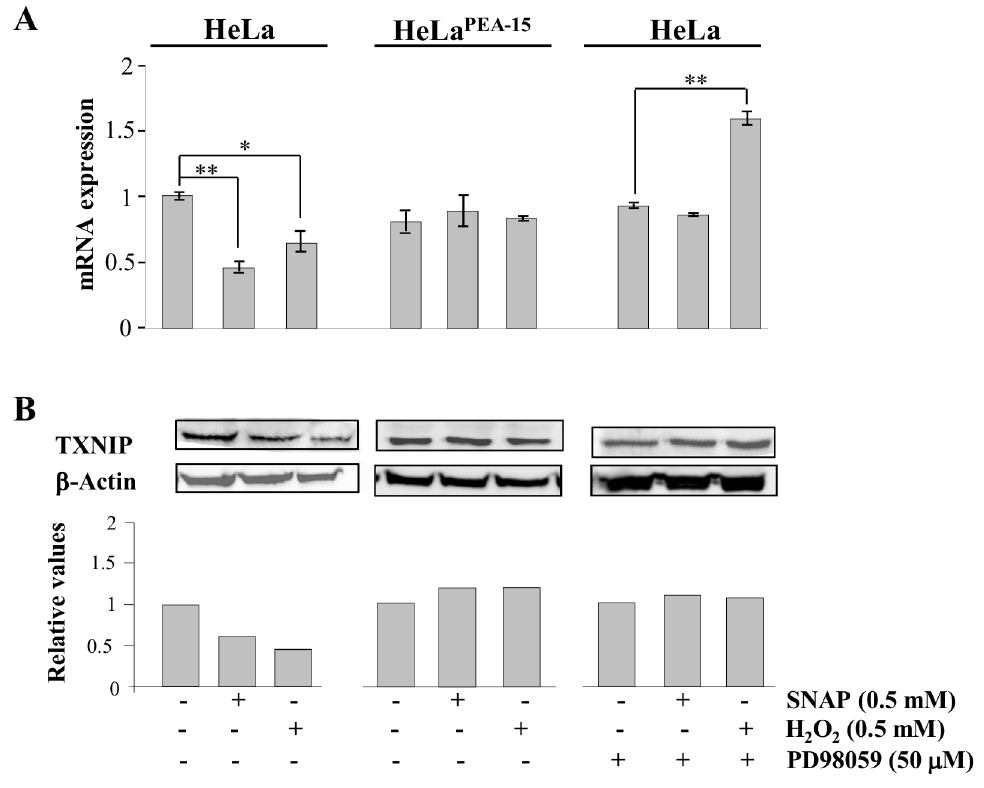
Figure 5. SNAP and H O -modulated TXNIP mRNA and protein levels in wild-type Hela cells and in HeLa cells expressing 2 2 PEA-15. ( A ) Relative levels of TXNIP mRNA determined by quantitative real-time PCR in HeLa cells wild-type, in HeLa cells expressing PEA-15, and in HeLa cells wild-type pre-treated with 50μM of PD98059 for 30 min as indicated (see Materials and Methods for details). All cell lines were treated with 0.5mM SNAP or 0.5mM H O for 2 h at 37°C. Values are reported in the bar 2 2 graphs and expressed as means ± S.D. (n = 3, * p < 0.05; ** p < 0.01). ( B ) wild-type HeLa cells and HeLa cells expressing PEA-15 were incubated with SNAP (0.5 mM) or H O (0.5 mM) for 2 h at 37°C. Cells were lysed and expression levels of TXNIP were 2 2 examined by western blotting. Western blot results are representative of four independent experiments. Histogram represents the ratio between the densitometric values of the protein bands corresponding to TXNIP and of β-actin (Lower panel). doi: